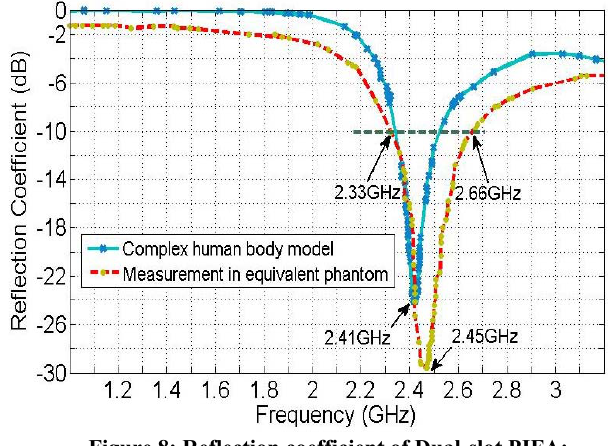
Figure 8: Reflection coefficient of Dual-slot PIFA: Measured vs. Calculated.